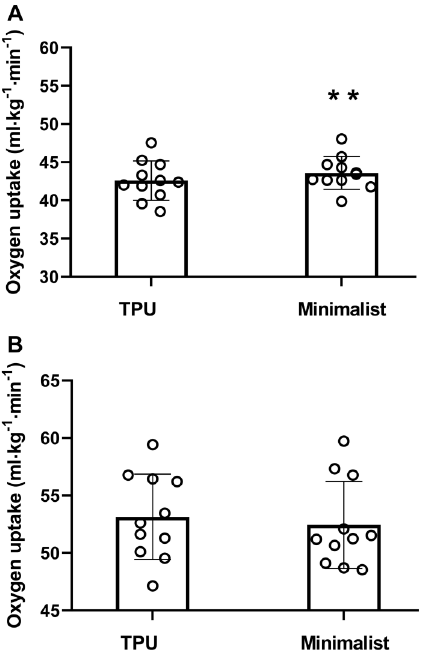
Figure 1. Oxygen uptake during constant-speed tests. A , Running economy at 12 km/h. B , Oxygen cost of running at individual average speed sustained during the 3-km running time- trial. TPU: midsole material composed by thermoplastic polyure- thane. Data are reported as means ± SD. **P o 0.05 ( t -test).